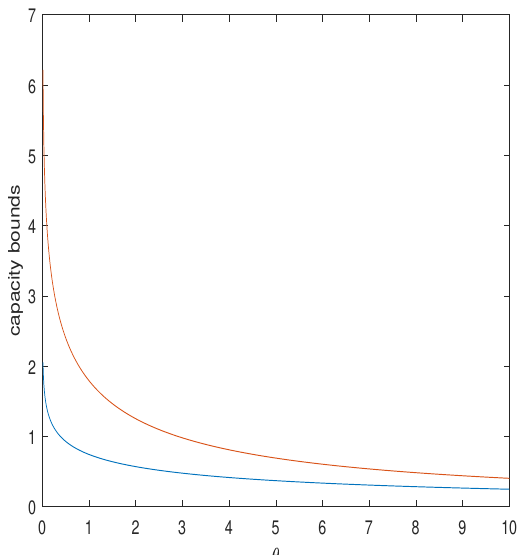
Figure 1. Capacity upper and lower bounds for g = 5. The blue curve is the lower bound as a function of θ and the red curve is the ordinary Jensen upper bound, given by ln ( 1 + g / θ ) .